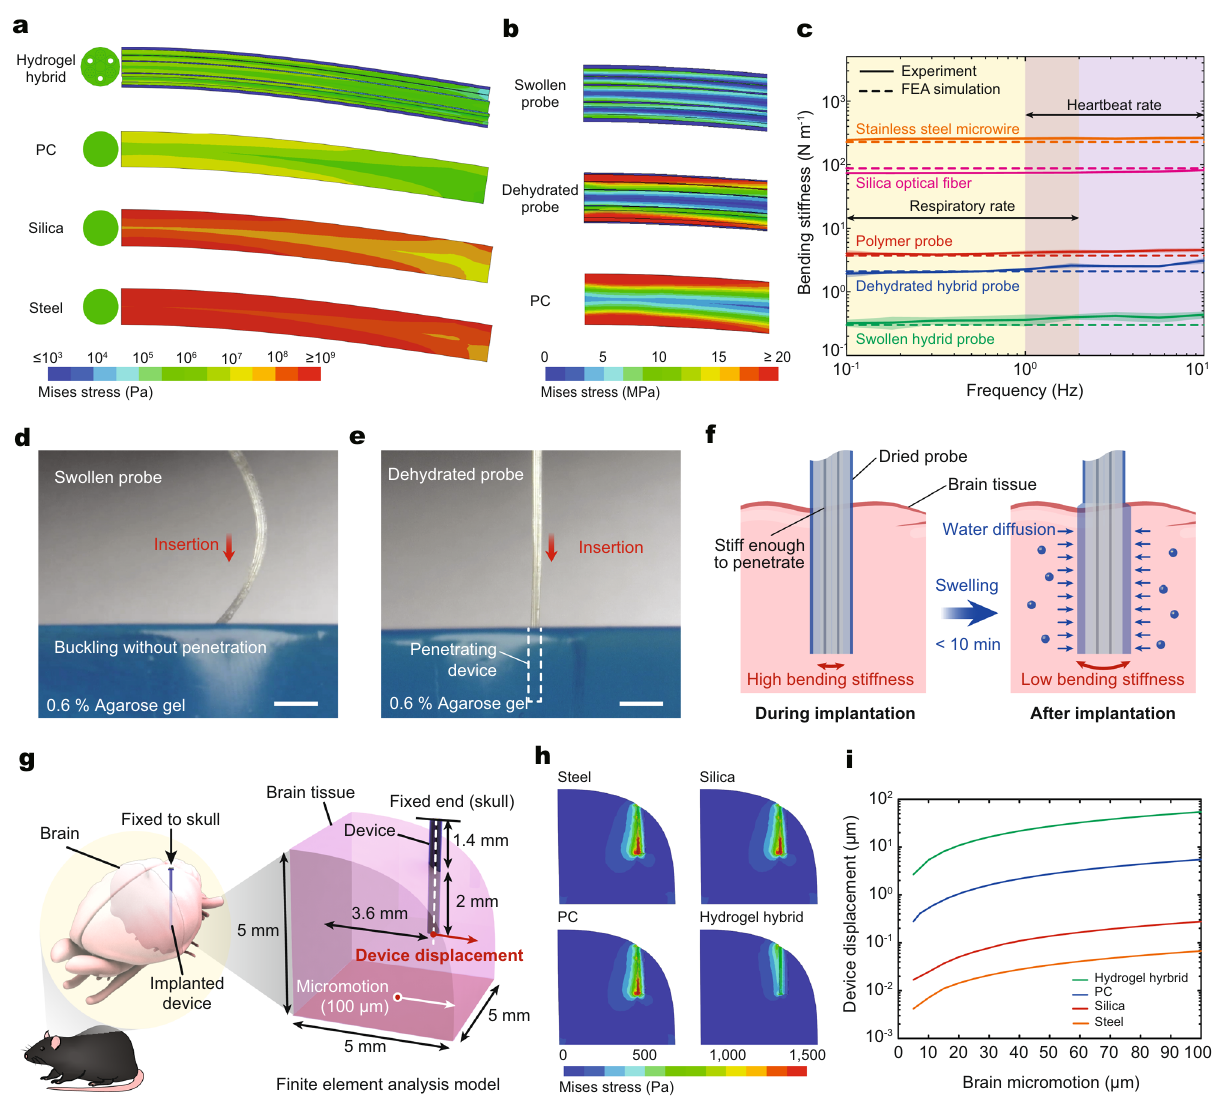
Fig. 2 Mechanical analysis of hydrogel hybrid probes. a Mises stress pro fi les for fi bers composed of stainless steel, silica, PC, and for the hydrogel hybrid probes under bending deformation. b Expanded view of the FEA results for a PC fi ber and a hybrid probe with a fully swollen and a dehydrated hydrogel matrix. The swollen probe exhibits mechanical isolation of individual polymer fi bers with discrete stress fi eld development. c Experimentally measured bending stiffness for stainless steel, silica, and PC fi bers and for the dehydrated and swollen hydrogel hybrid probes in the frequency range of 0.1 – 10 Hz. d , e Insertion of the hybrid probe with fully swollen ( d ) and dehydrated ( e ) hydrogel matrix into the phantom brain (0.6% agarose) at a speed of 1 mm s − 1 . Scale bars: 1 mm. f A conceptual illustration of the adaptive bending stiffness of the hydrogel hybrid probes. The dehydrated probes exhibit bending stiffness suf fi cient for initial insertion. Following implantation, probes absorb water from the surrounding tissue and convert into compliant swollen state. g A schematic illustration for the FEA model of the implanted device fi xed to the skull during the brain micromotion. h Mises stress pro fi les within the brain tissue for stainless steel, silica, and PC fi bers and for the dehydrated and swollen hydrogel hybrid probes at 100 µ m lateral micromotion of the brain tissue. i The displacement for stainless steel, silica, and PC fi bers and for the dehydrated and swollen hydrogel hybrid probes during 0 – 100 µ m lateral micromotion of the brain tissue. Lines and the shaded areas in c represent the mean and the standard deviation, respectively ( n =